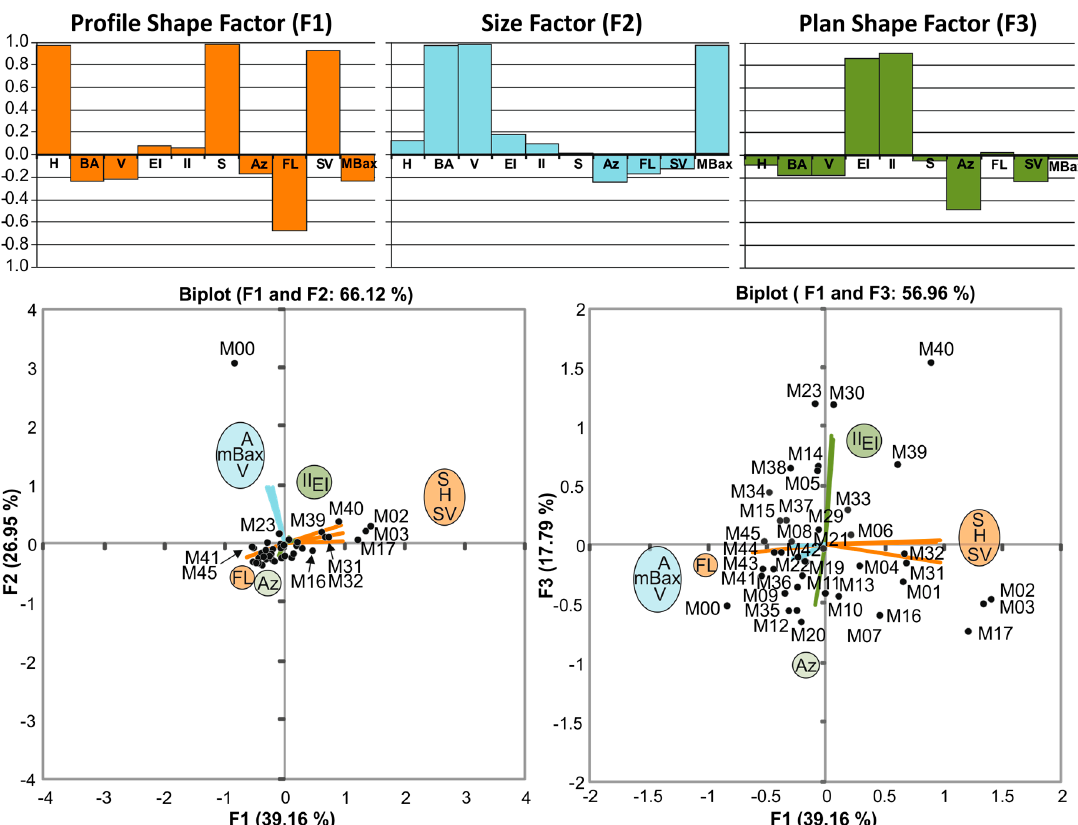
Figure 3. Factor loading plots of the three main principal components that account for 84% of the total variance of the edifices. Factor loads explain the correlations between the PCs and the original variables. Bar plots illustrate which variables are driving the PCs. We have named each factor according to the most significant variables of the analysis. The PCA biplots allow visualization of both the observations (edifices) and the variables among F1-F2 and F1-F3 relationships. Edifices are displayed as points while variables are displayed as linear axes. Standardized values are used to represent the factors.